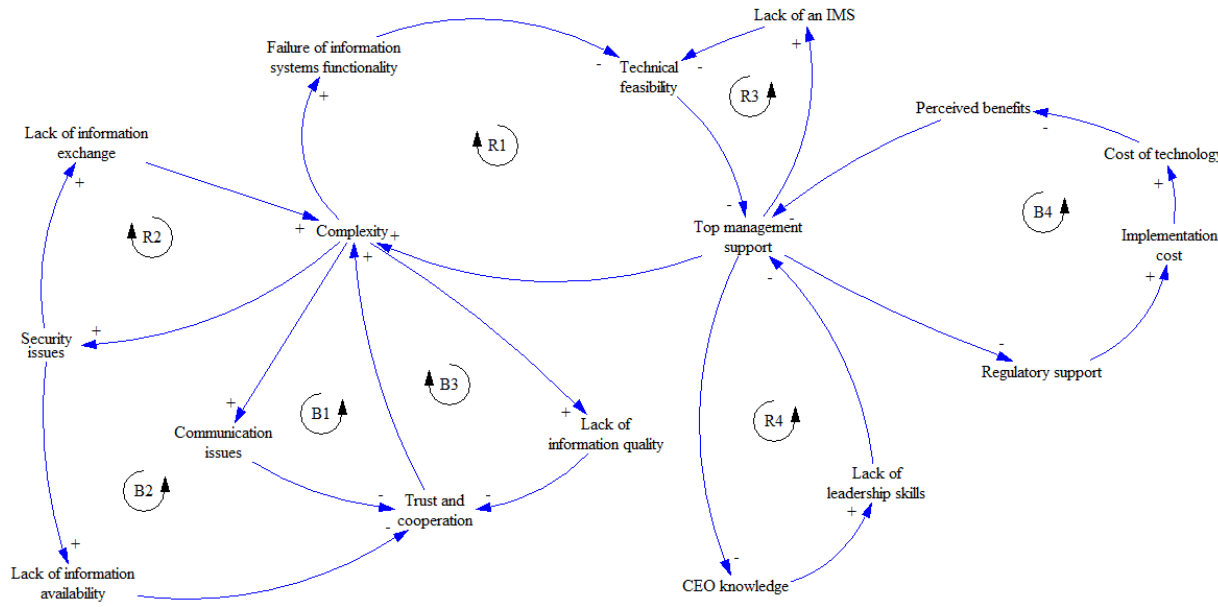
Figure 3. Causal loop diagram.